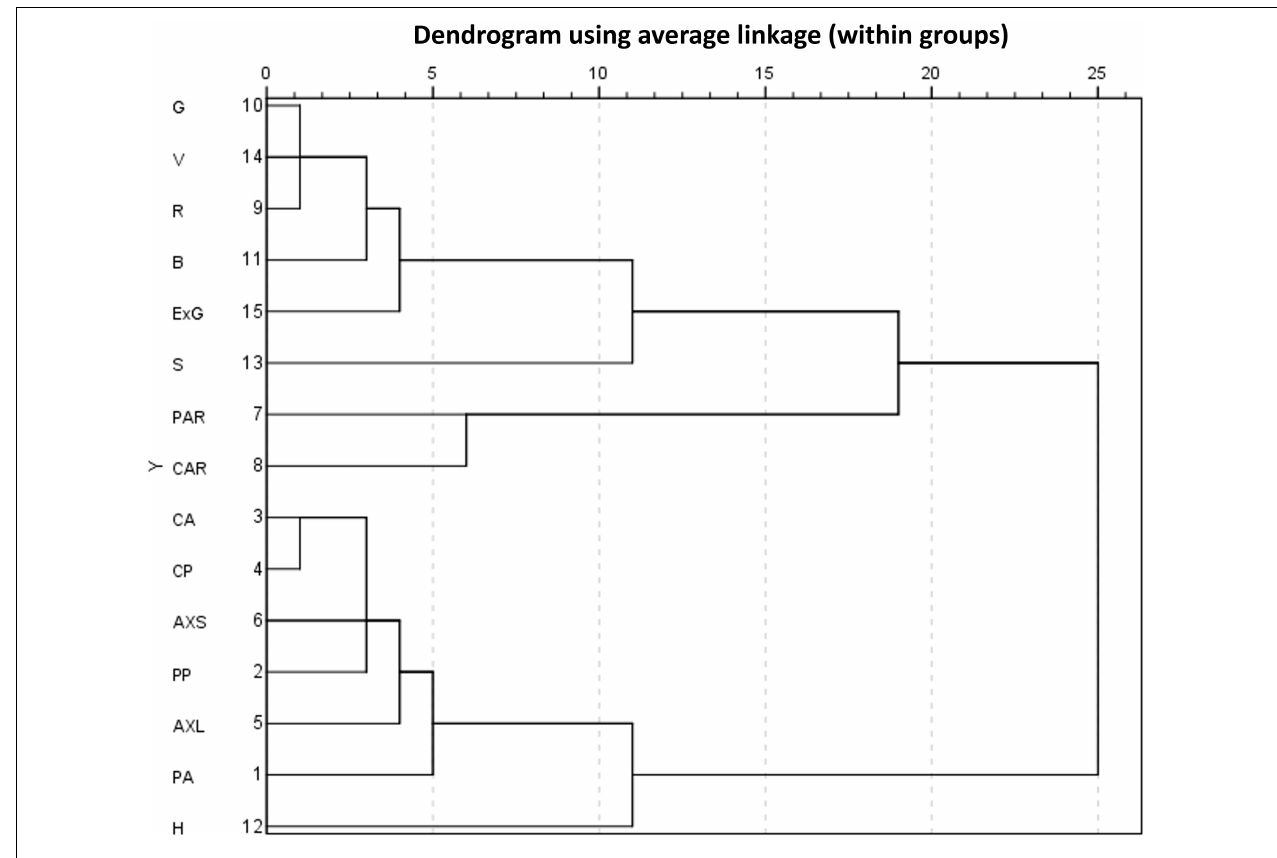
FIGURE 6 | Hierarchical cluster analysis of static traits in lettuce.